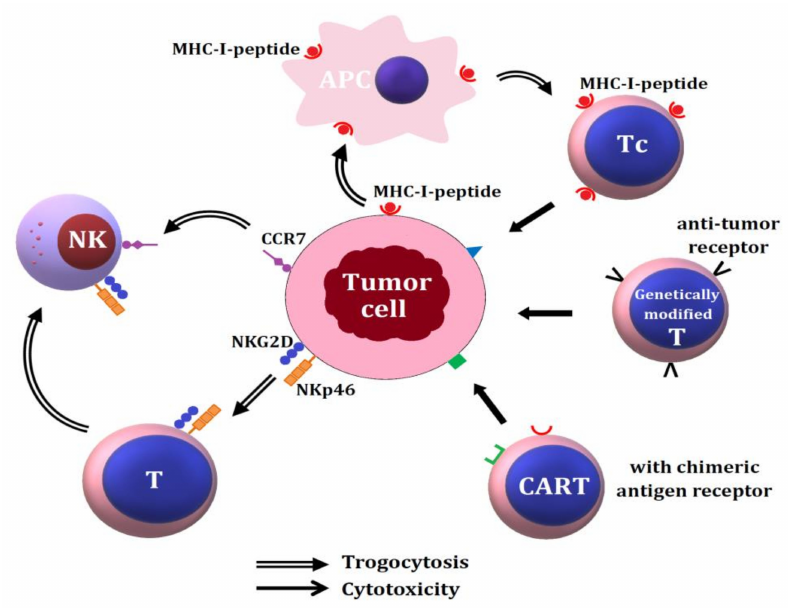
Figure 3. The roles of trogocytosis among tumor cells and different immune-related cells in tumor immunity. The MHC-I-peptide complex expressed on tumor cells is trogocytosed by APC and then transferred to cytotoxic T cells (Tc) for tumor surveillance and cytotoxicity. The surface-expressed NKG2D and NKp46 molecules on tumor cell are trogocytosed by T lymphocyte and then are transferred to NK cells for tumor killing. The chemotactic receptor CCR7 on tumor cells can be trogocytozed by NK cells for direct cytotoxicity. In addition, the genetically modified and chimeric antigen receptor (CAR)-T lymphocytes (CART) can directly kill tumor cells by expressing the specific anti-tumor receptors for binding with the tumor